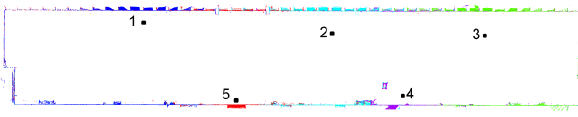
Figure 6. Horizontal cross section through the registered scans where viewpoint locations are highlighted by numbered dots